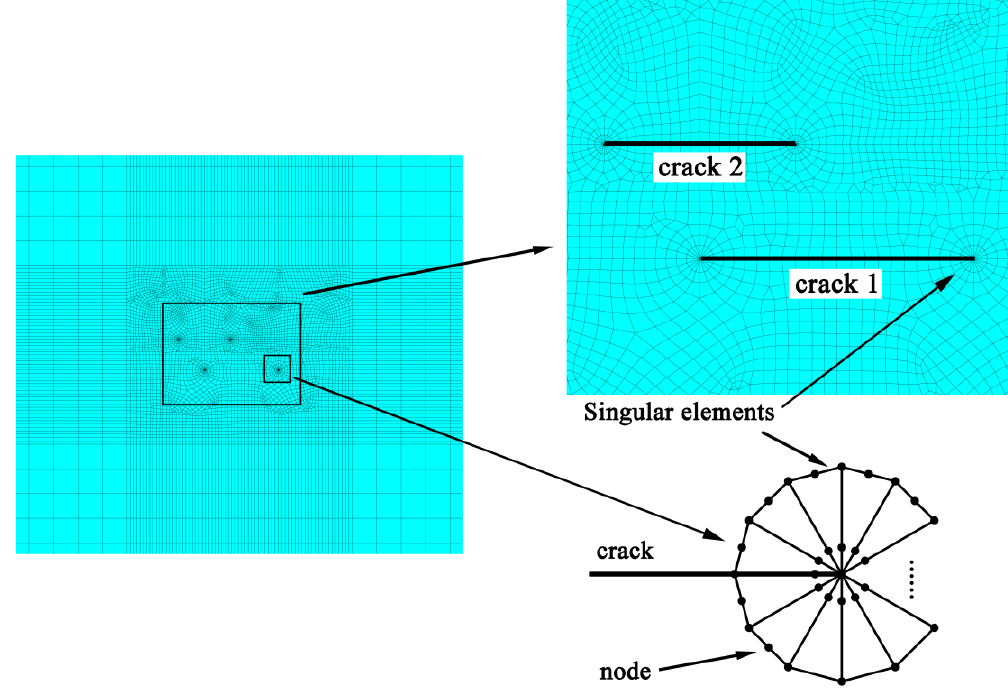
Figure 7. Mesh model of the plate with double cracks.